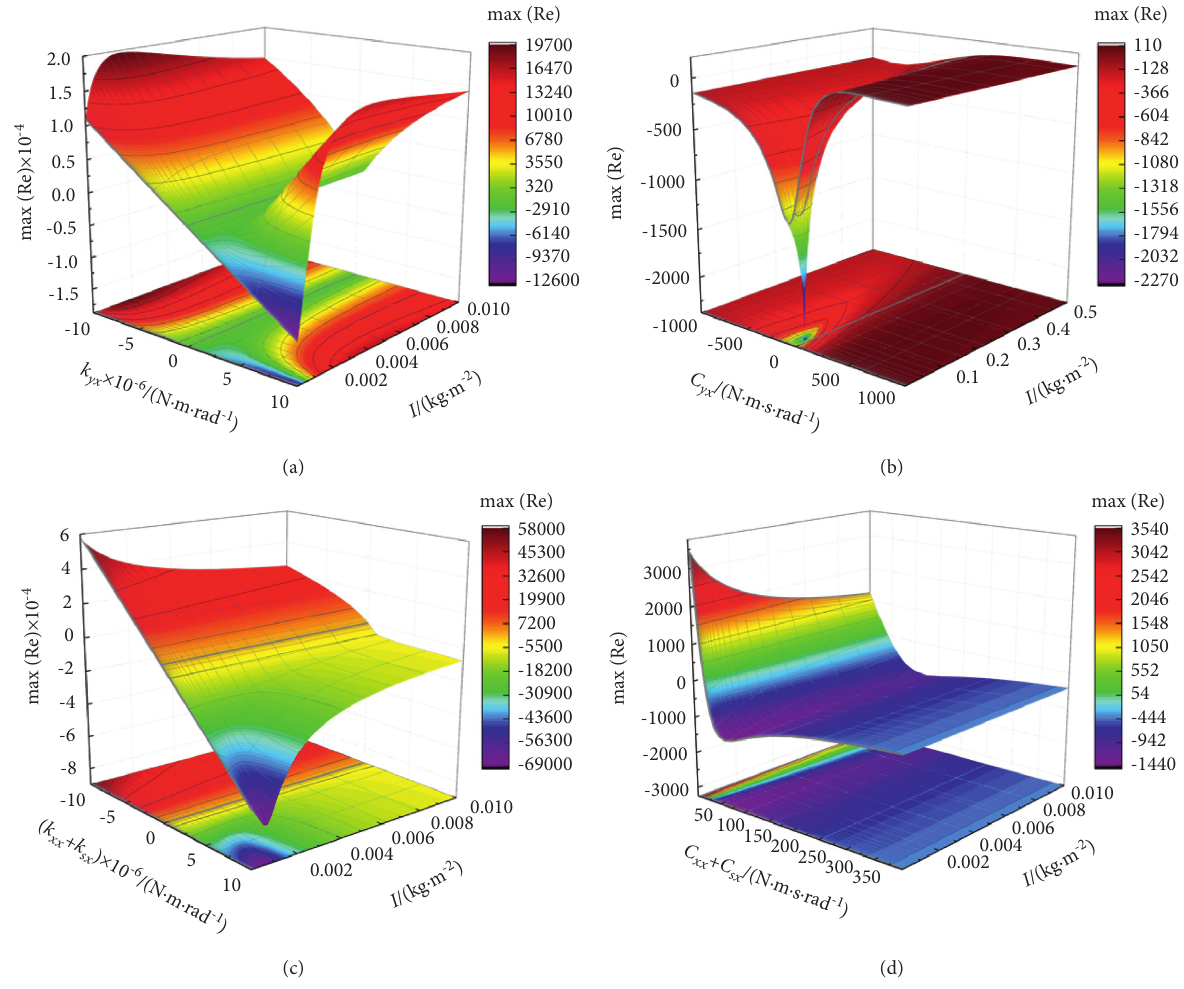
Figure 5: Interaction between rotational inertia and stiffness or damping parameters: (a) I − k I − ( c xx + c sx